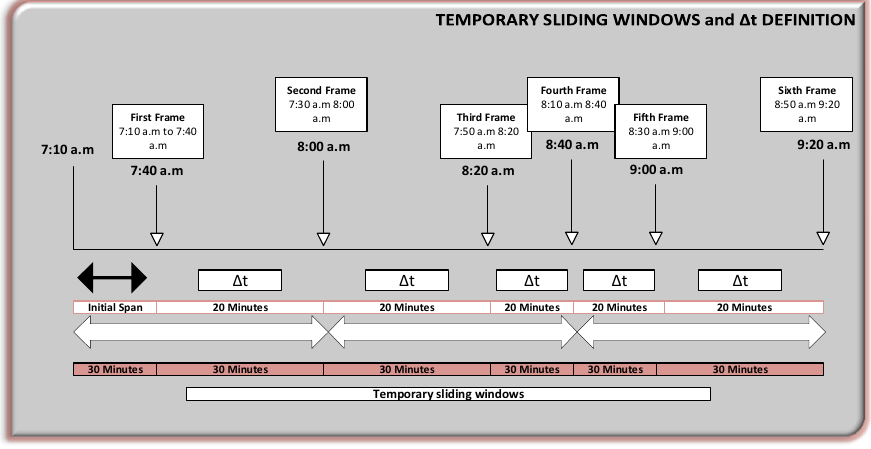
Figure 5. Distribution of temporary windows and Δt definition.